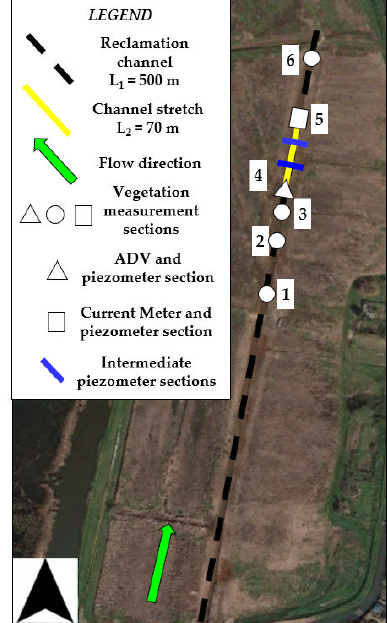
Figure 1. Location of the experimental area (indicated by the yellow filled circle), in hydraulic connection with the adjacent Massacciucoli Lake (indicated by the red filled circle). (From https://www.esa.int/ESA_Multimedia/Images/2010/07/La_Toscana_vista_da_Envisat, modified). Geosciences 2020 , 10 , 47 The 500-m long vegetated reclamation channel was covered by emergent Common reed, at a dormant phenological stage [1]. Field hydrodynamic and vegetation measurements were taken at six cross sections of the vegetated reclamation channel (Figure 2).